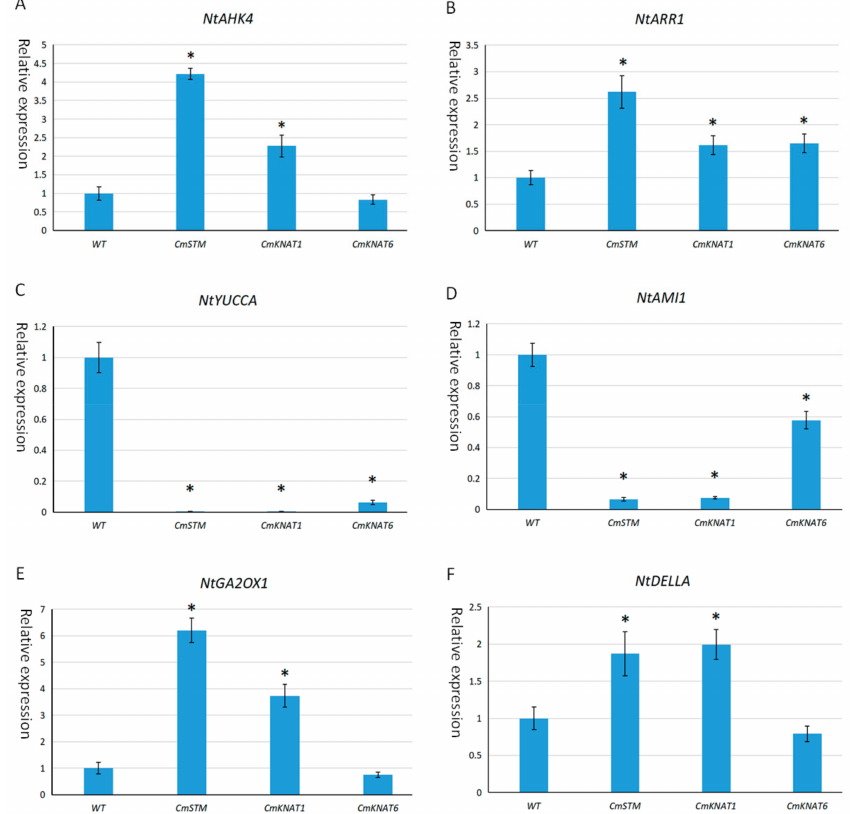
Figure 11. Detection of expression of hormone pathway-related genes in tobacco plants overex- pressing chrysanthemum KNOX gene (Asterisks indicate a significant difference in gene expression compared to wild-type plants (WT)); ( A , B ) show the relative expression of genes related to cytokinin pathway; ( C , D ) show the relative expression of genes related to auxin pathway, and ( E , F ) show the relative expression of genes related to gibberellin